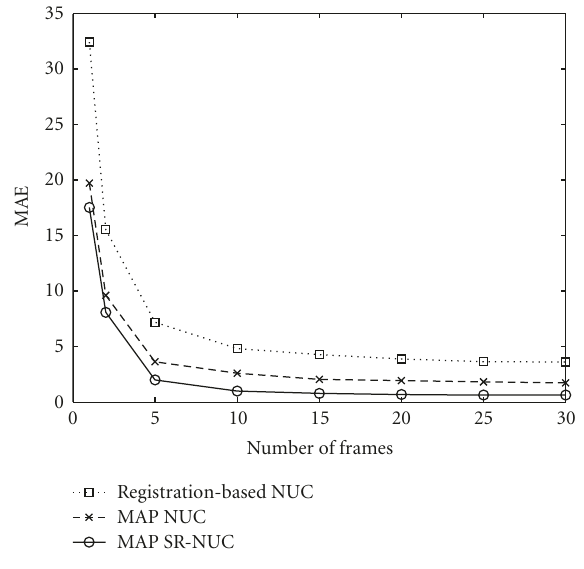
Figure 3: Mean absolute error for the estimated biases as a function of P (the number of input frames).